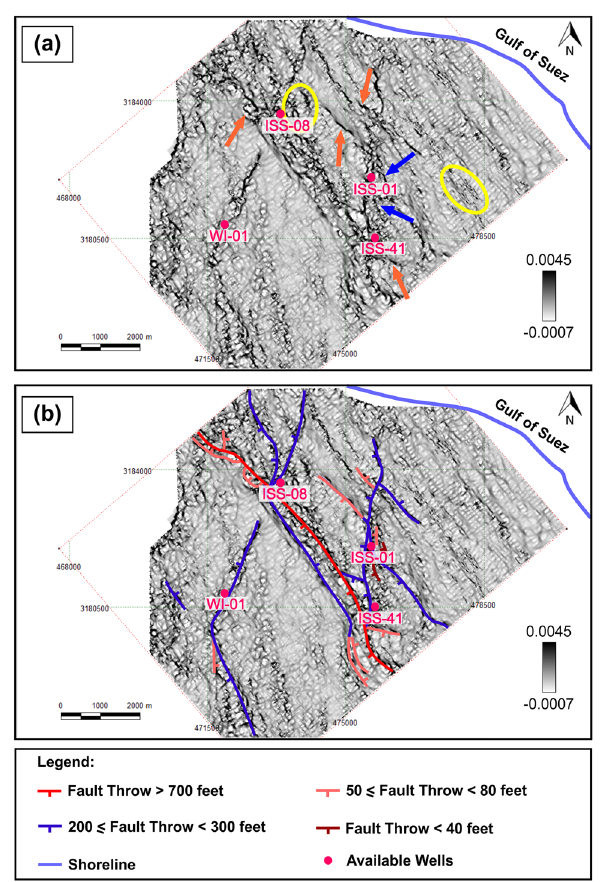
Fig. 11 A time slice at 252 ms demonstrates the positive curvature attribute: a without and b with the extracted fault patterns. The blue arrows point to small-scale faults with offset displacement less than 40 feet, which are not detected by the similarity attribute. While the orange arrows confirm and magnify the detection of micro faults that the similarity attribute resolves. The yellow ellipses might reflect the area of a fracture